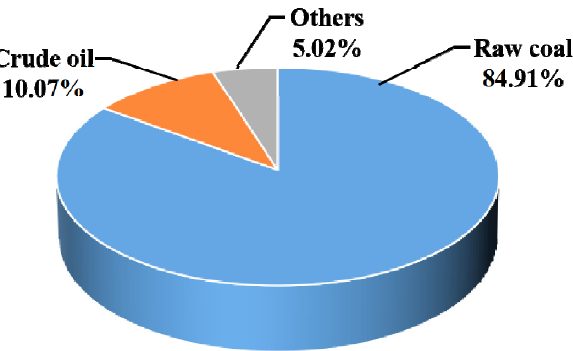
Figure 4. Environmental impacts to ADP of each substance in blended cement with CML method.